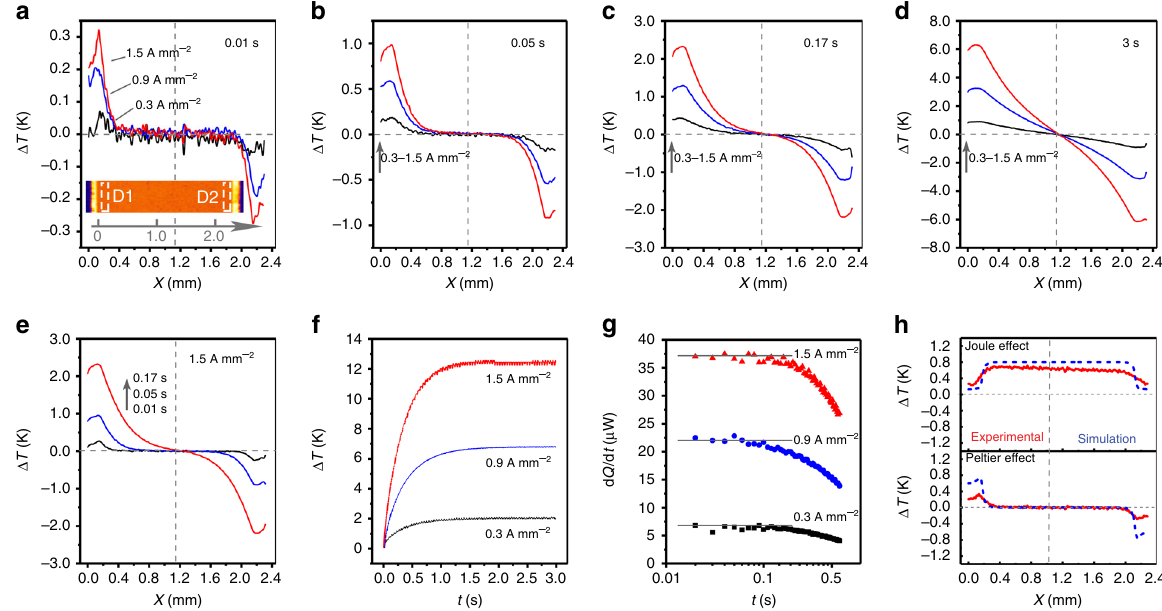
Fig. 3 Transient infrared characterization of Peltier effect. Peltier-effect-induced temperature distribution in the current direction at current densities of 0.3, 0.9, and 1.5 A mm − 2 for a 0.01 s, b 0.05 s, c 0.17 s, and d 1 s. e Peltier-effect-induced temperature distribution in the current direction at 0.01, 0.05, and 0.1 s with a current density of 1.5 A mm − 2 . f Temperature difference at the two contacts versus biasing time for different current densities. g Measured Peltier heating/cooling power with respect to time. h Experimental and simulated temperature distribution contributed by the Joule heating and Peltier effect under a current density of 1.5 A mm − 2 for 0.01